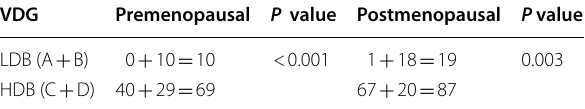
Table 5 Risk of carcinoma in HDB and LDB in premenopausal and postmenopausal age